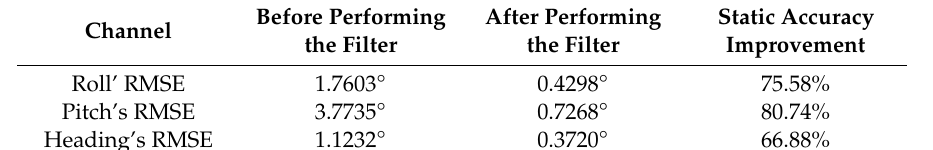
Table 3. RMSE of roll, pitch, and heading before and after the proposed filter in static test.